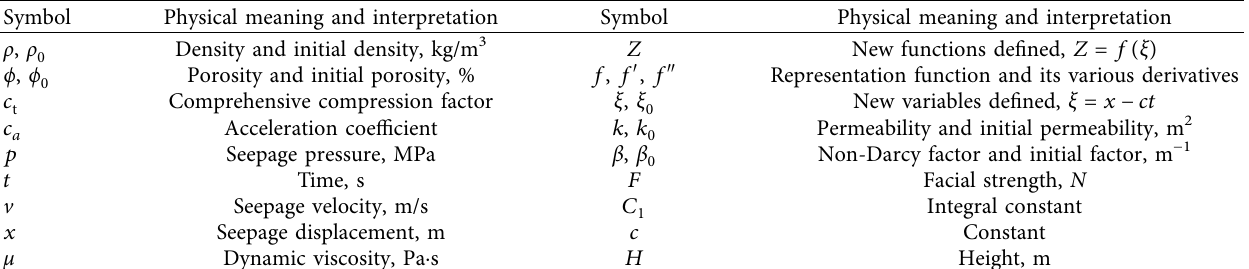
Table 3: Symbol comment